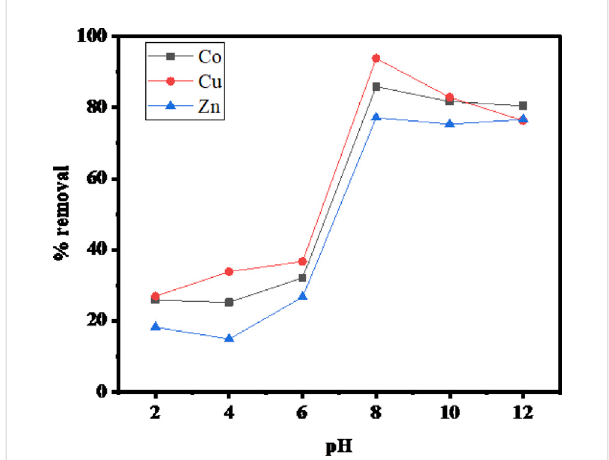
FIGURE 1 pH versus the rate of metal ion uptake (operating conditions: adsorbent dose 0.1 mg, contact time 1.5 h, metal ions concentration 100 ppm, and temperature 25 °